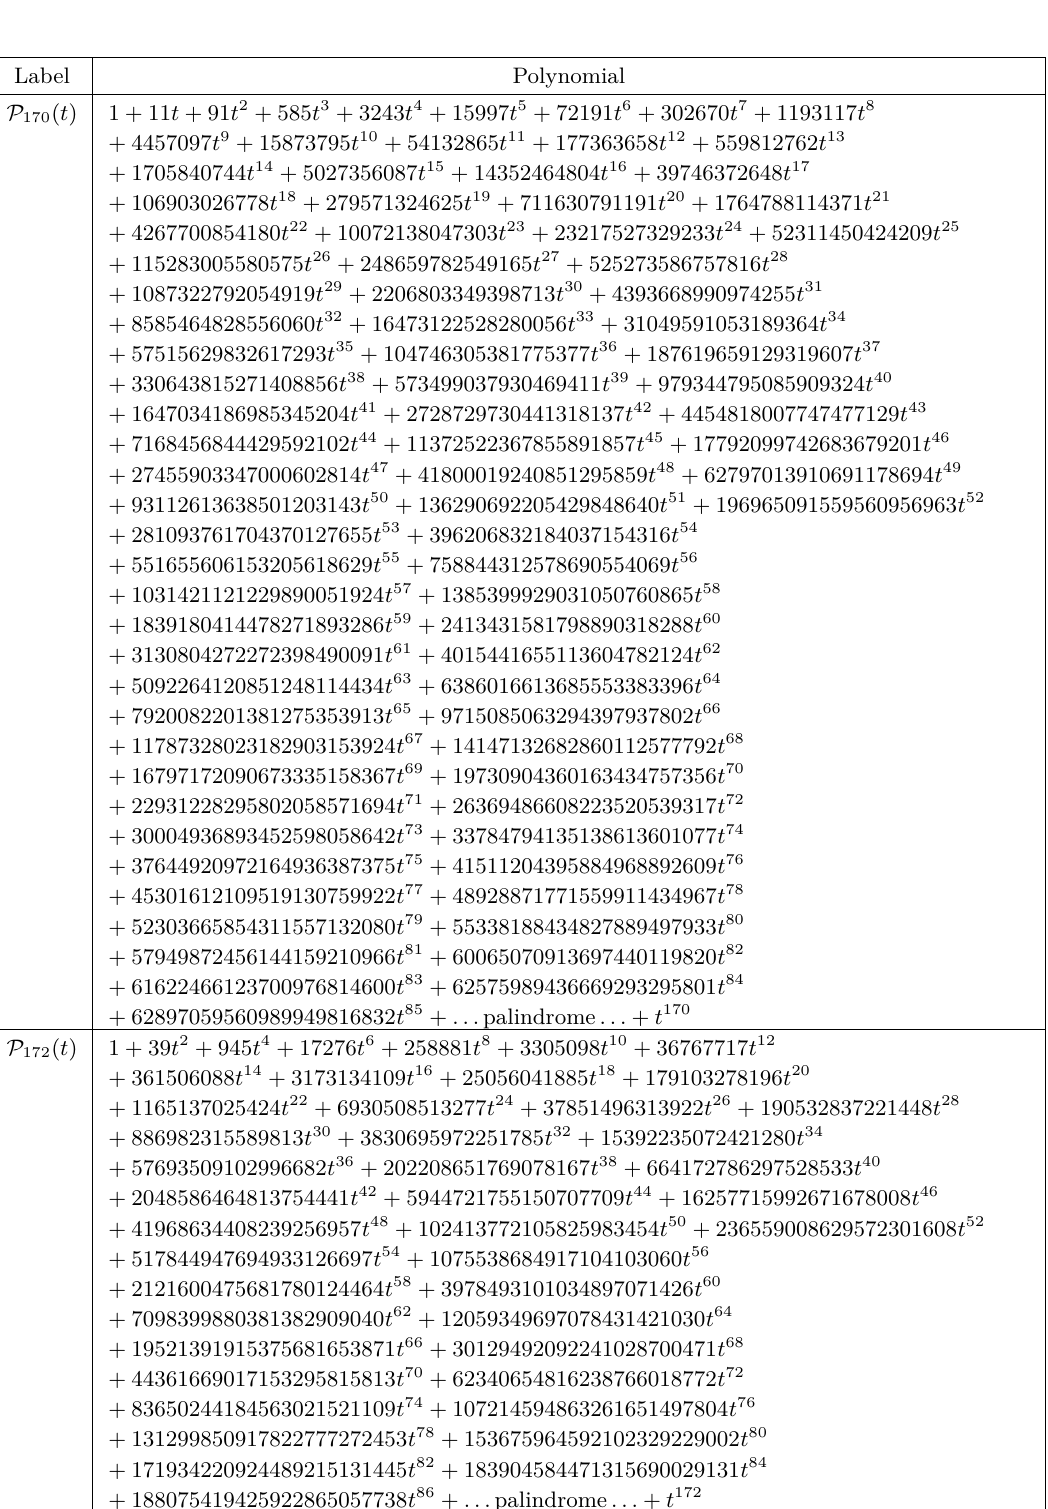
Table 39. Palindromic polynomials